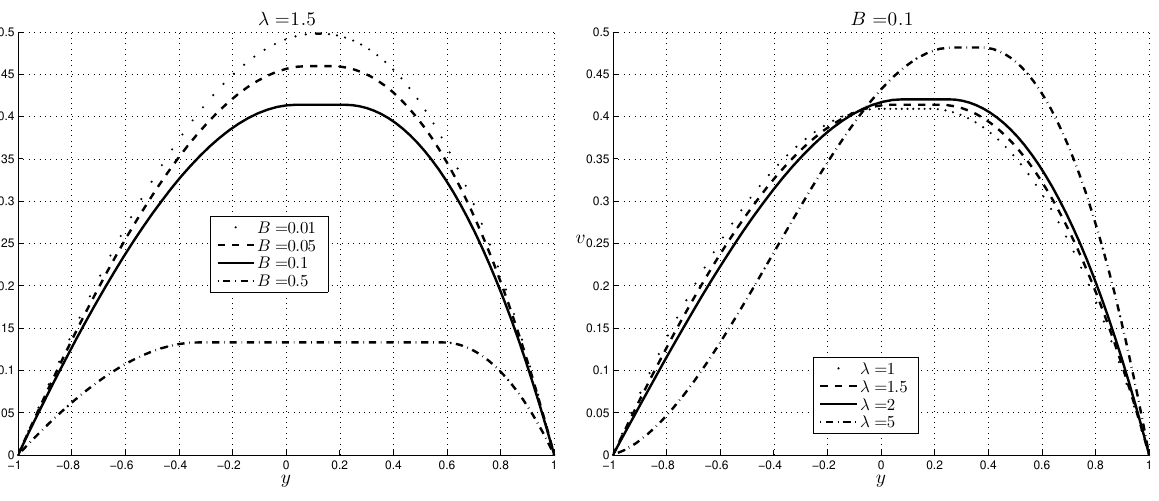
Figure 6. Case 1 : profile of the